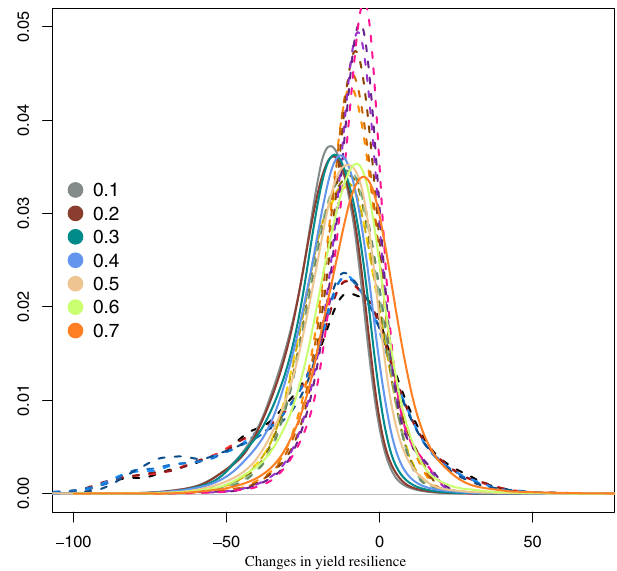
Fig. 6 Idealised climate service and changes in resilience. Spatial probability density functions of the ensemble resilience changes (2021 – 2040 minus 1986 – 2005) estimated for each ideotype (dotted line) and for the simulations integrating the idealised climate service with different skill (bold lines and according to the colours from 10% to